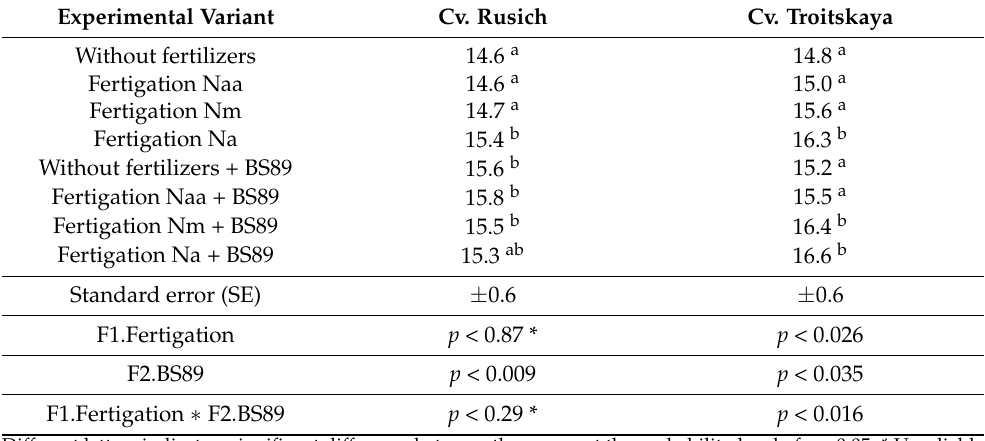
Table 3. Chlorophyll content in the plant leaves of two strawberry cultivars (average of three years). Experimental